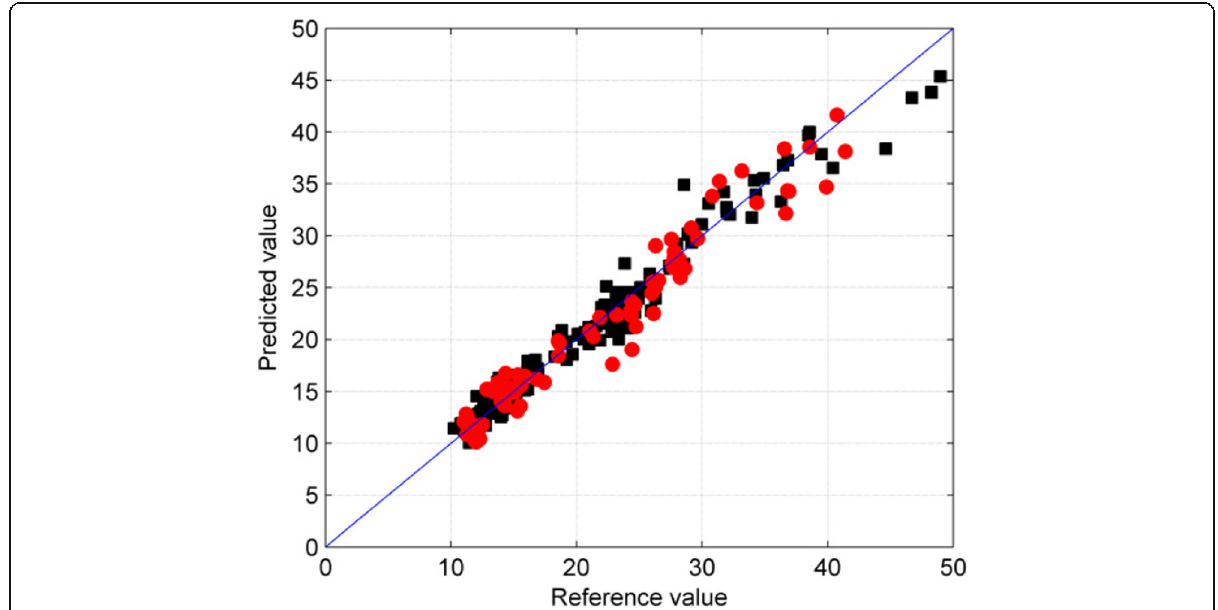
Fig. 4 The correlation between predicted and reference values for MCUVE-SPA-LSSVM model. The blank panes and red circles represent the calibration samples and validation samples, respectively. Samples on diagonal line indicate their predicted values which are equal to reference